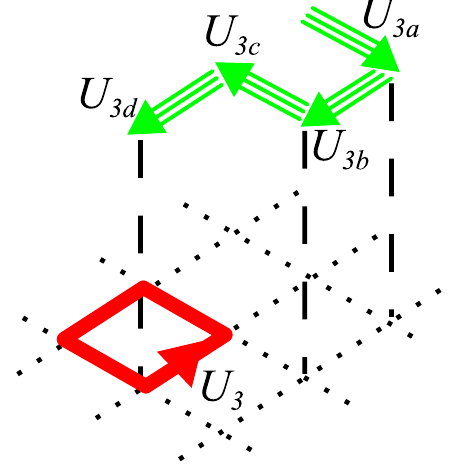
Fig. 3 Sublattice of the representation given in Fig. 2 with the links labeled